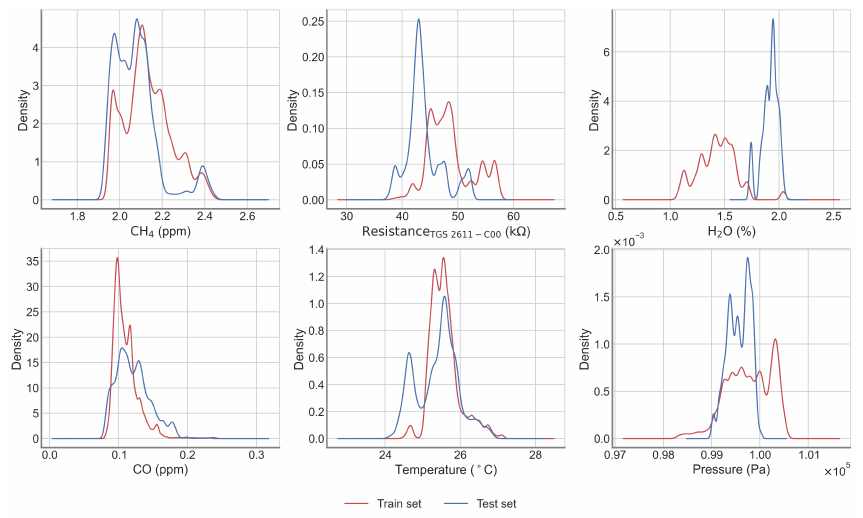
Figure A3. Density distribution of the training (red) and test (blue) set for the worst case (50).